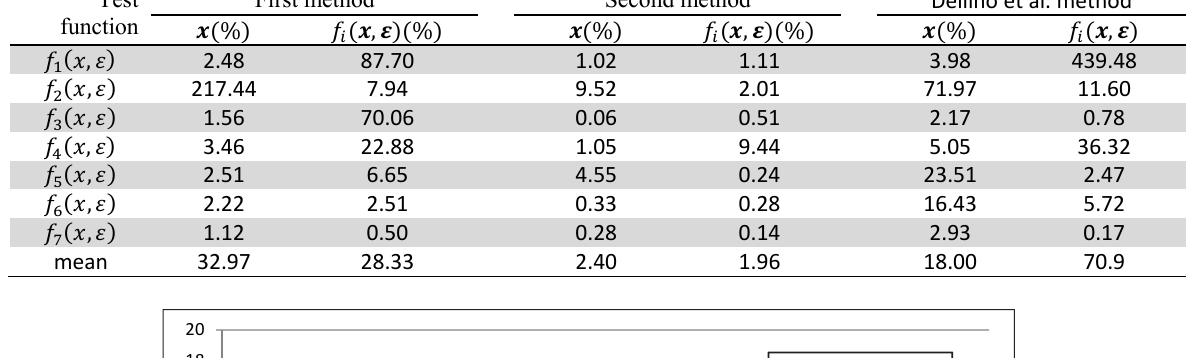
Relative deviations of the two proposed methods and Dellino et al. method from reference value